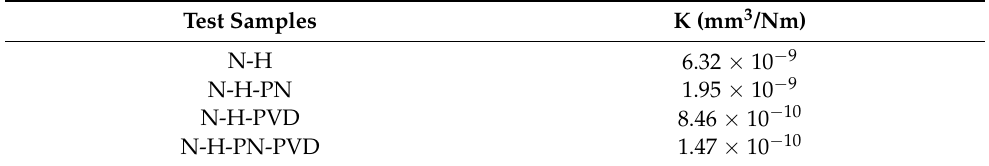
Table 6. The wear coefficient of the tested